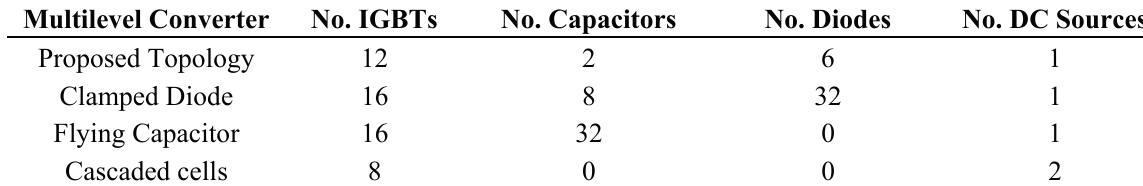
Table 5. Comparative analysis for nine levels DC/AC multilevel